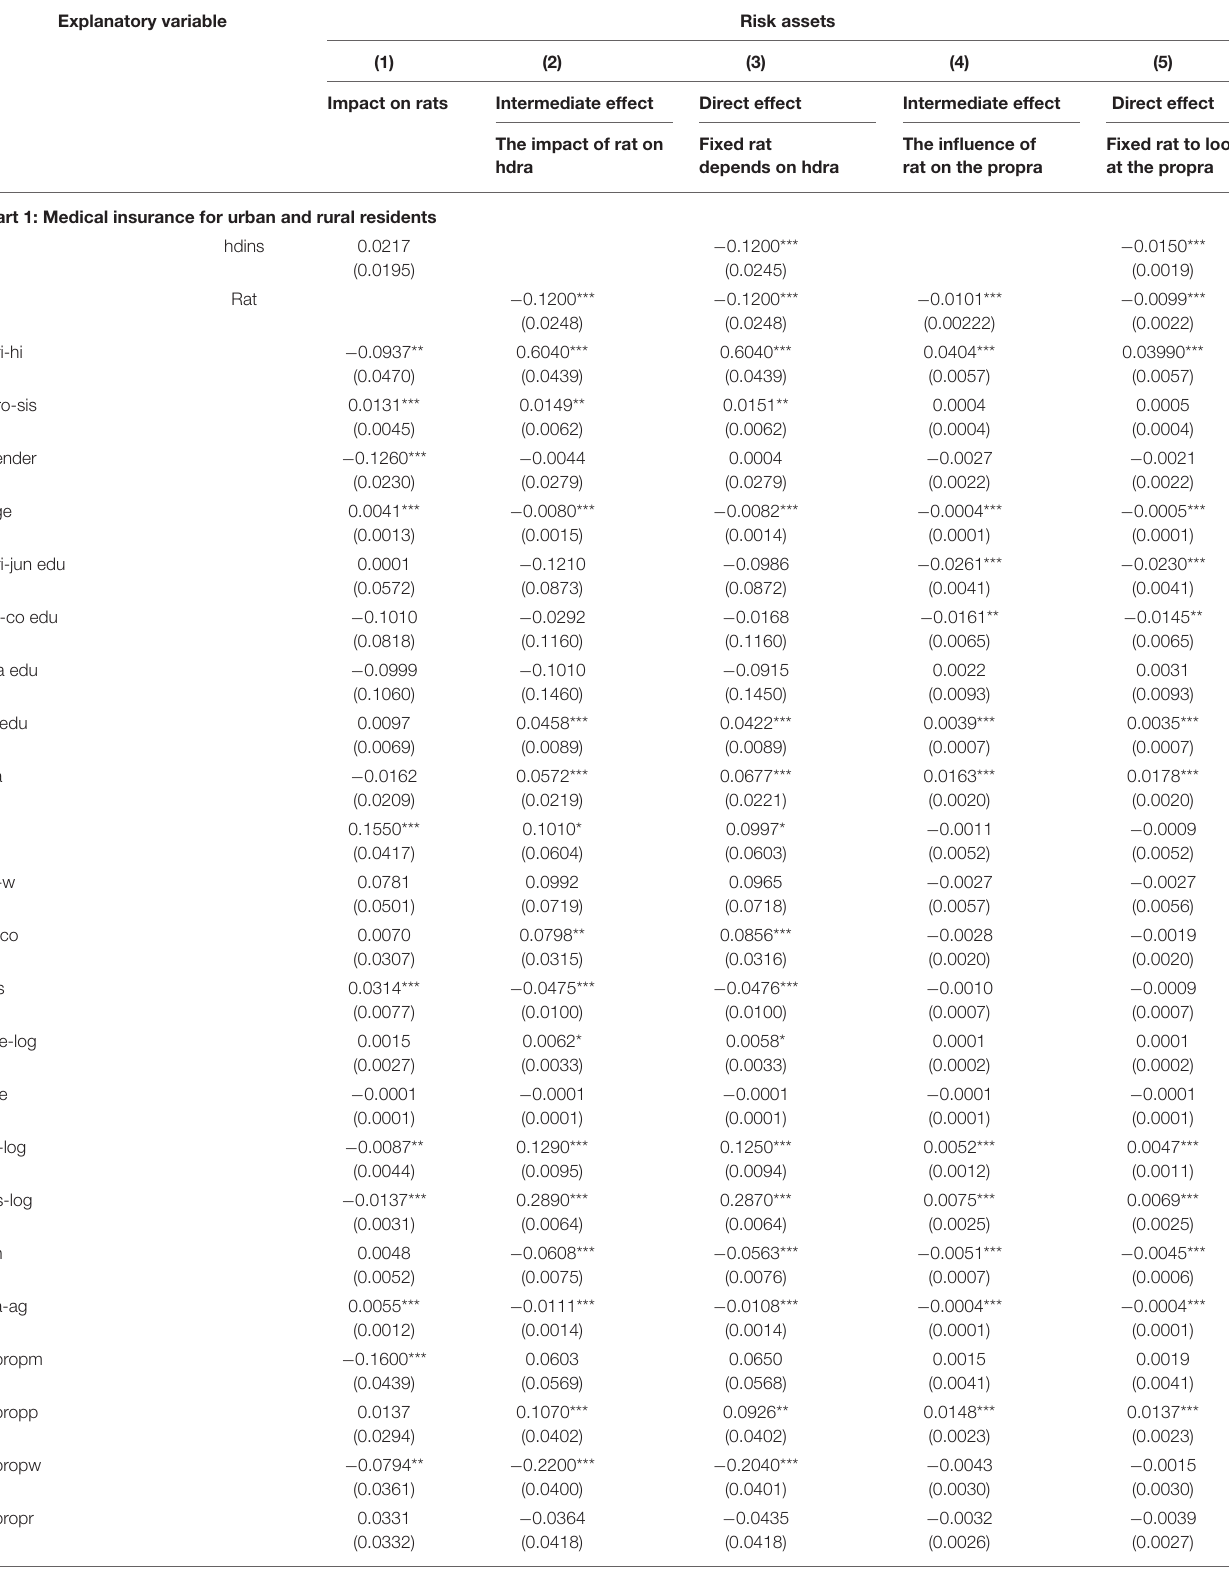
TABLE 3 | Intermediary effect regression (risk